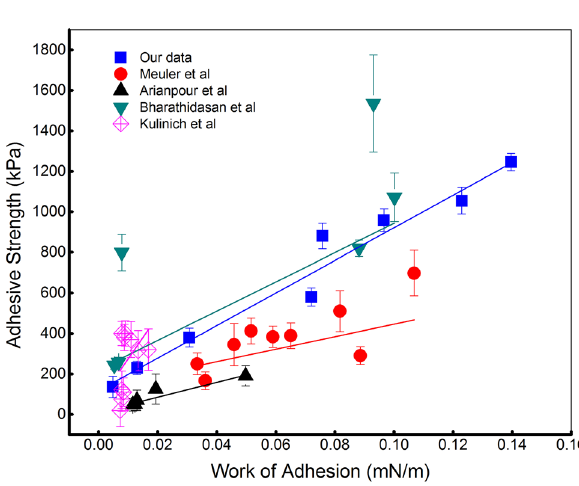
Figure 3. The work of adhesion in correlation with adhesive